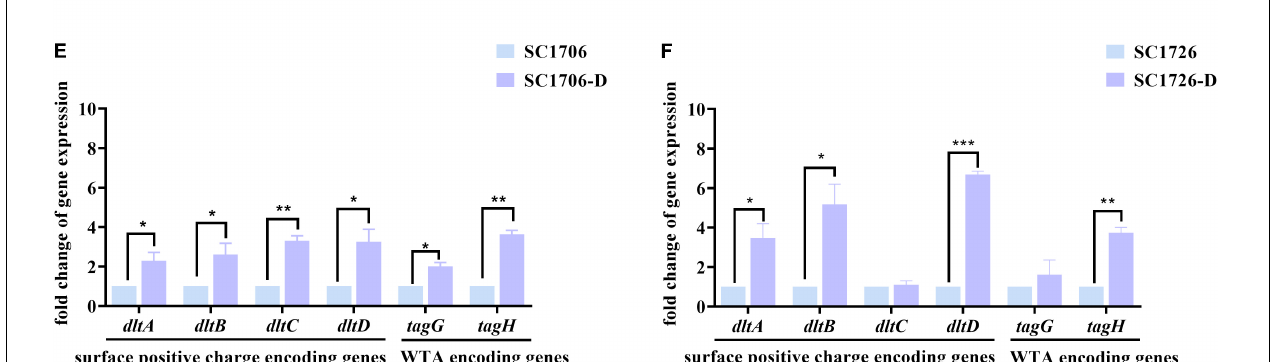
Frontiers in Microbiology |